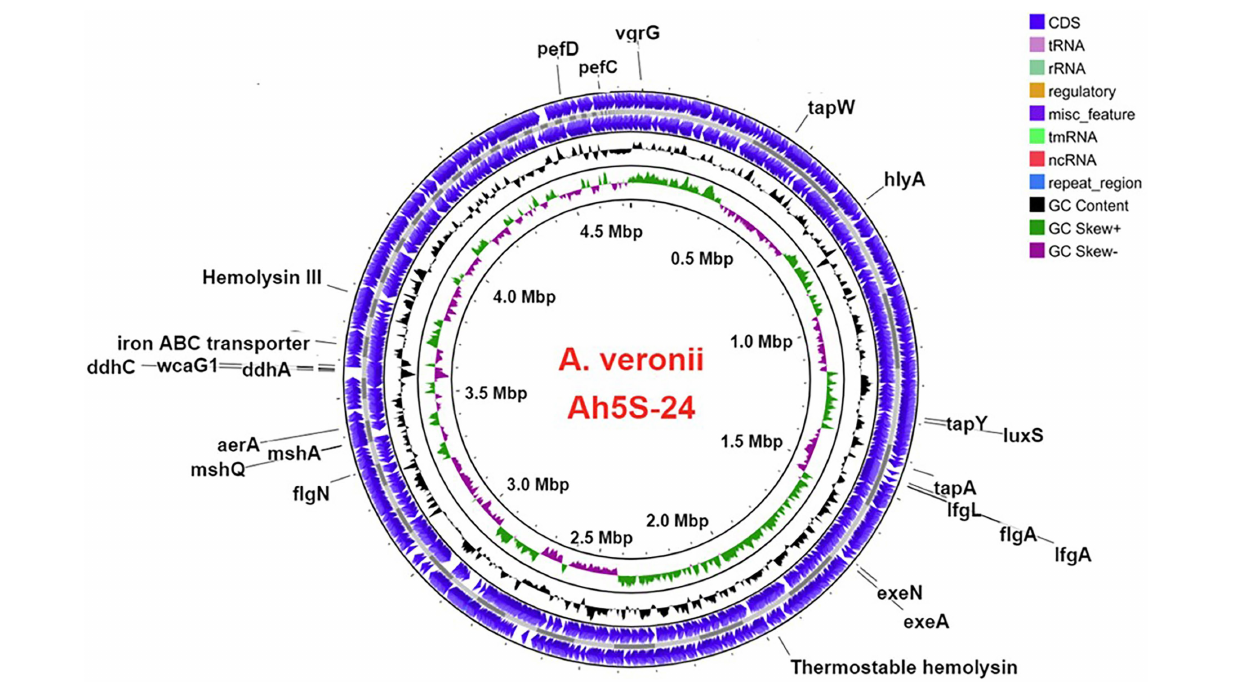
FIGURE 2 Circular map showing the loci for different virulence genes in the genome of Aeromonas veronii strain AhS5-24. Motility and adherence genes detected included the lateral flagella ifgA and IfgL genes; polar flagella flaA and flgN genes; tap type IV pili tapA and tapY ; fimbriae pefC and pefD genes. The mannose-sensitive hemagglutinin (MHSA) genes were represented by mshA and mshQ while the hemolysin genes included hylA , hylIII, and TSH . Iron acquisition was represented by the iron ABC transporter protein and genes associated with capsule formation included the ddhA , ddhC, and wcaG1 genes. Quorum sensing and biofilm formation genes were represented by luxS . The T2SS was represented by exeA and exeN genes while T6SS was represented by the vgrG